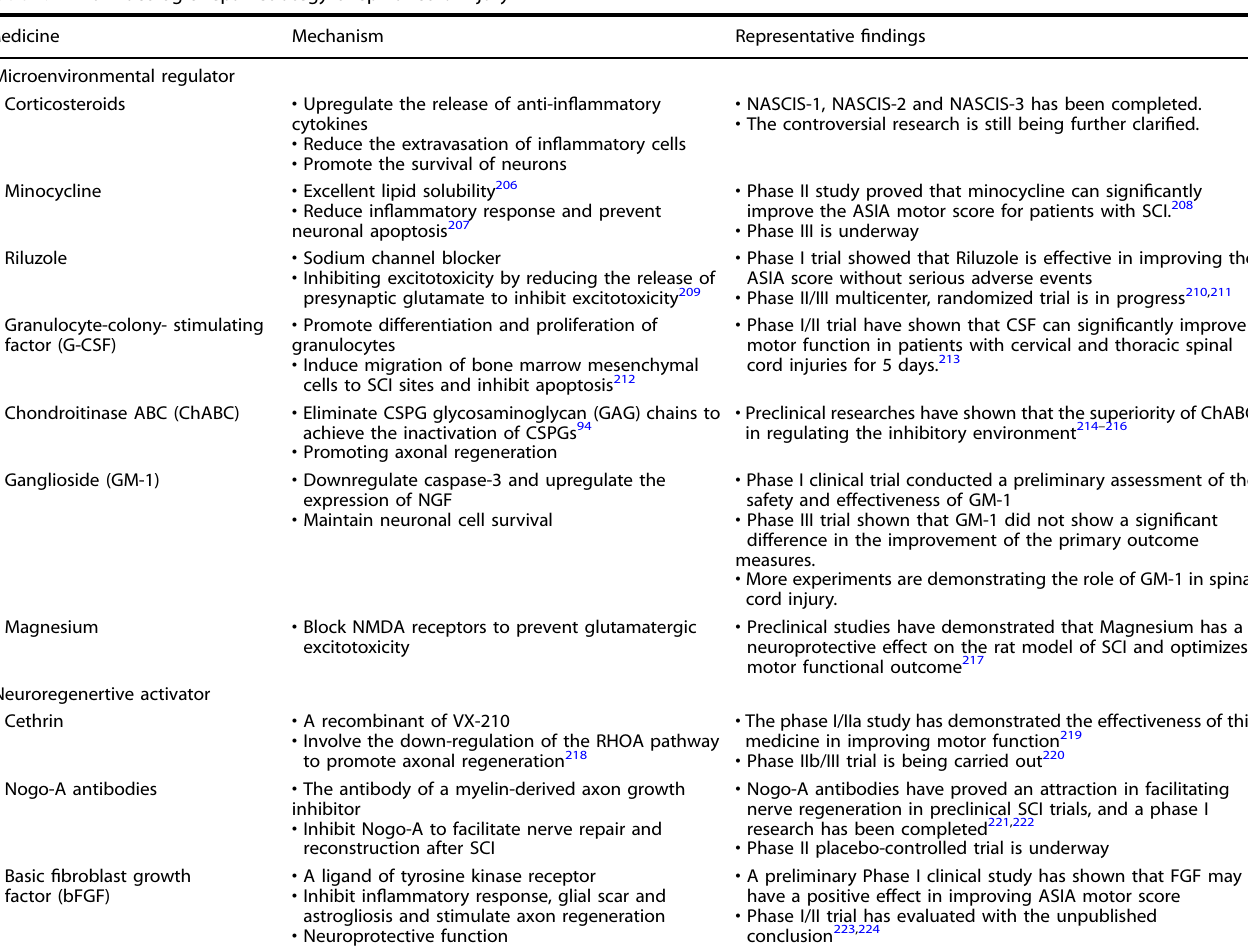
Table 1. Pharmacologic repair strategy of spinal cord injury Medicine